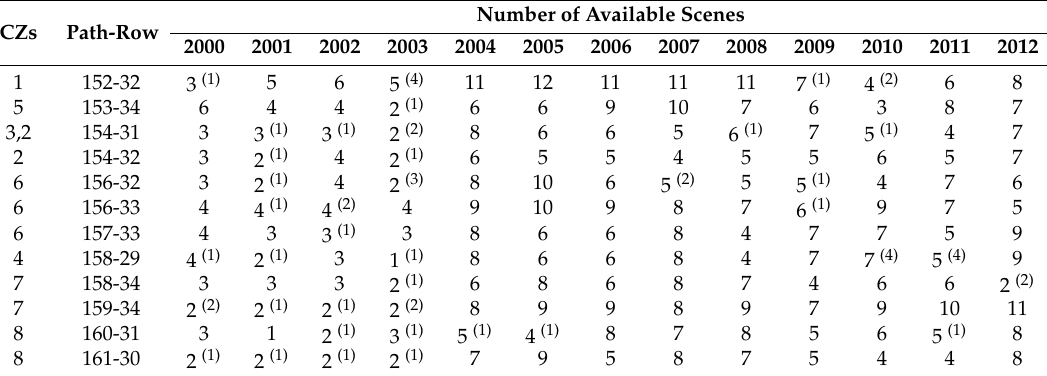
Table 1. Number of Landsat scenes available per year and reference site (named and sorted after the paths and rows of the WRS-2 tiles). From these data sets HR-iCE and HR-CVP maps were derived. The reasons for omitting single years from HR mapping are indicated by numbers in brackets and explained below the table.